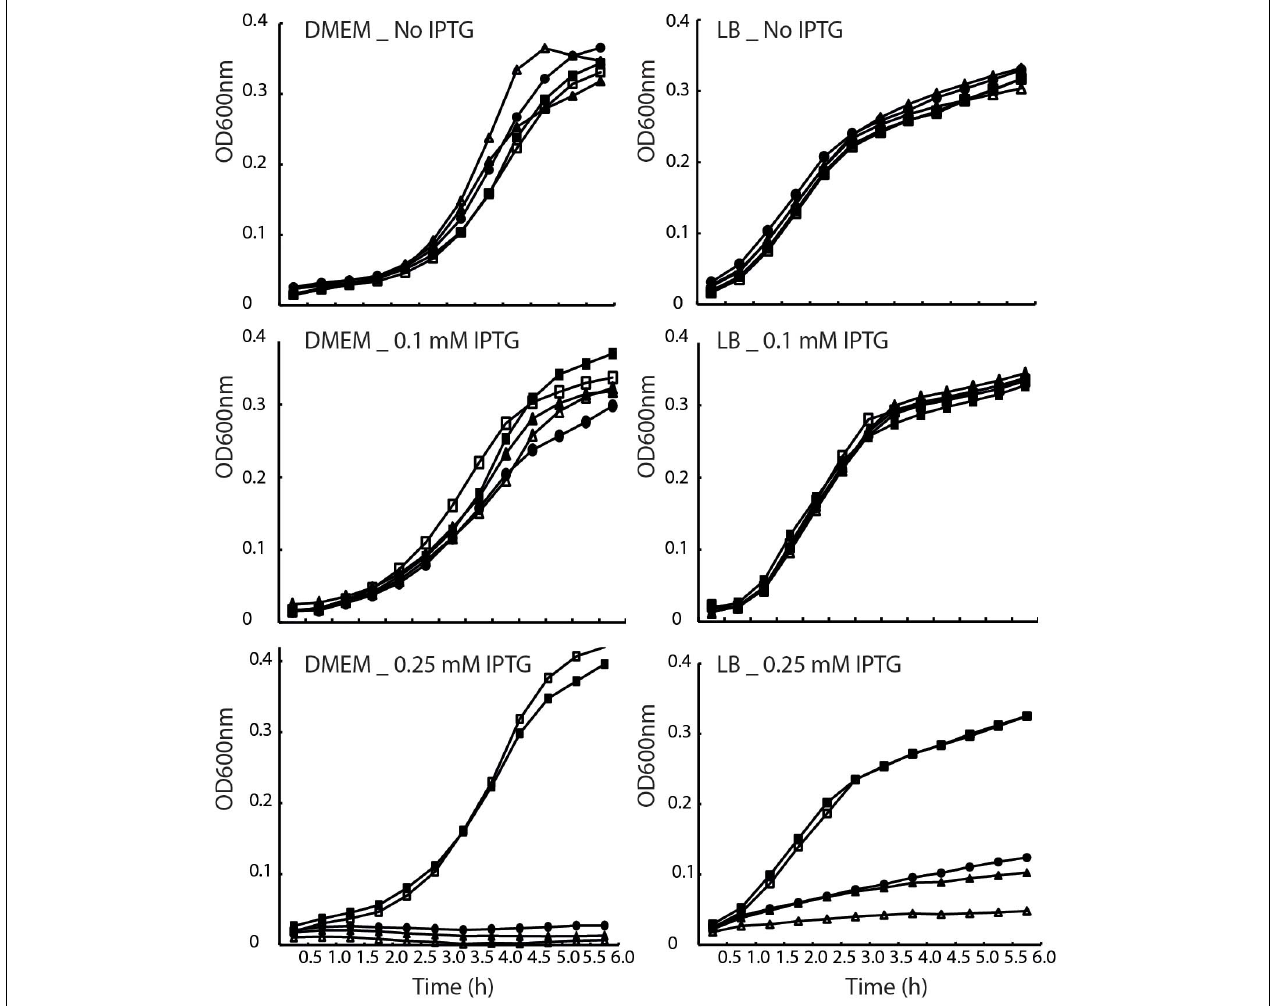
), and EPEC (cid:49) escV transformed with EscV wt -His ( • ), (cid:50)